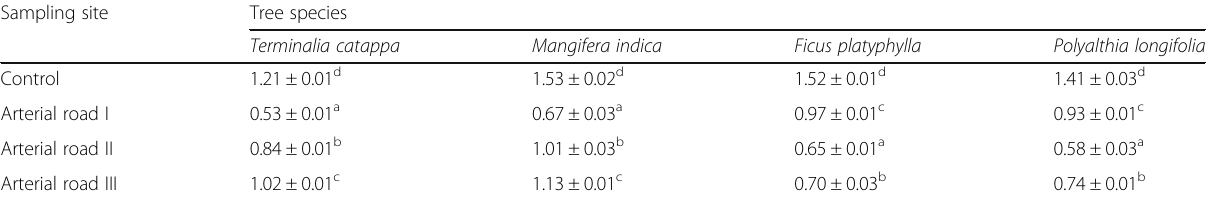
Table 7 The effect of vehicular pollution on total chlorophyll (mg/g) contents of selected tree species in the Kumasi Metropolis Sampling site